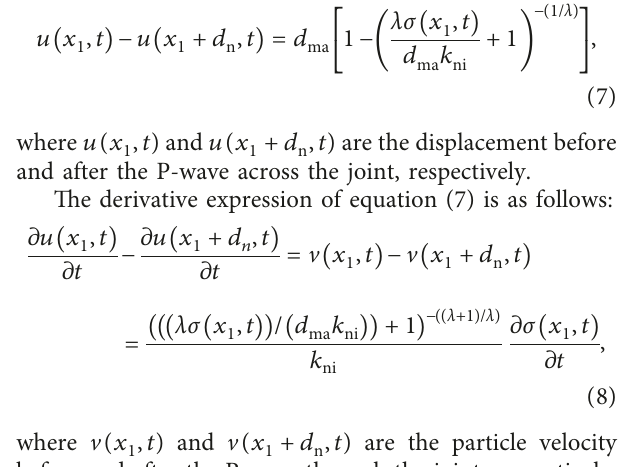
λ i , in which (cid:31)